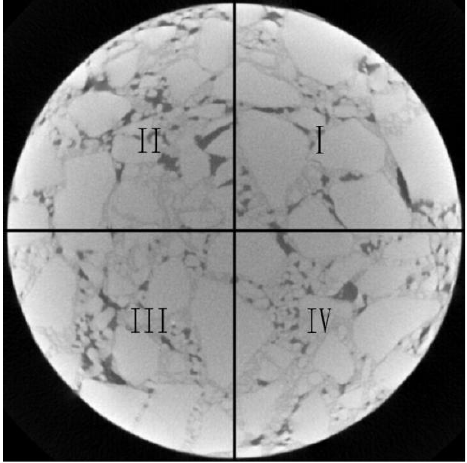
9 of 19 Figure 12. Validation of the separation effect of various components. ( a ) Aggregates. ( b ) Voids. ( c ) Asphalt mortar. As shown in Figure 12, the advantage of the improved OTSU threshold separation method is more obvious than the traditional methods. The aggregates, voids and asphalt mortar in CT images can be effectively segmented by annular partition combined with the OTSU threshold separation algorithm. The boundary of different components in the CT image is clear and continuous, and there is no component information missing in the CT image of asphalt pavement. The effectiveness of the OTSU algorithm in segmenting the aggregates and voids of the asphalt mixture has also been verified in some of the literature [24 – 26]. Obviously, segmenting different components in a CT image of a pavement core sample by the improved OTSU threshold separation method is reliable. 3. Evaluation Index of Component Homogeneity for Asphalt Pavement During the analysis process of CT images, it is necessary to extract and analyze the image features of target objects. The purpose of the image process in this paper is to reflect the distribution homogeneity of aggregation, voids and asphalt mortar in asphalt pave- ment. For the asphalt pavement that is constructed evenly, the different components should be distributed evenly in horizontal and vertical directions. Under the ideal condi- tion, the pavement components in some local regions will not be too much or too little, and there is no agglomeration phenomenon. Generally, the geometrical features of aggre- gates in asphalt mixtures can be described by three independent components: form, an- gularity, and surface texture [27]. Among which, the form and angularity of aggregates has an important influence on the distribution homogeneity of the asphalt mixture. For an aggregate particle, its shape is the closest to an ellipse [28]. The area of the equivalent ellipse is equal to the aggregate area. According to the area and position of aggregate par- ticles in a CT image, the homogeneity of aggregate distribution in the asphalt mixture can